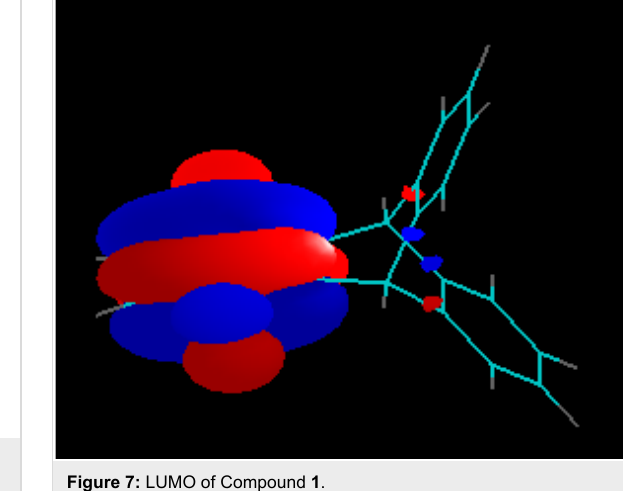
Figure 7: LUMO of Compound 1 .